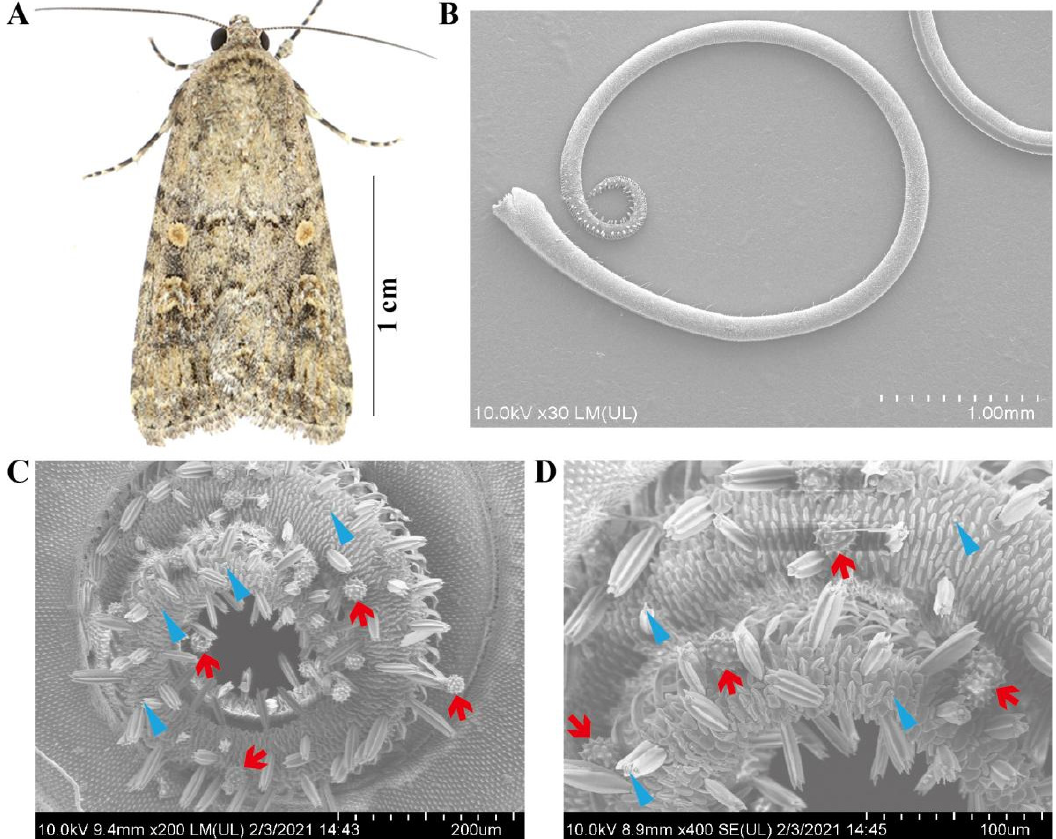
Figure 1. The beet armyworm, Spodoptera exigua, and the pollen adhering to the proboscis of this species. ( A ) Representative images of adult S. exigua. ( B ) Overall view of the adult proboscis. ( C , D ) Proboscis with a(cid:6)ached pollen grains from species of Asteraceae, probably a representative of the tribe Heliantheae. The red arrow denotes the a(cid:6)ached pollen grains on the proboscis, and the blue arrow indicates the sensilla.